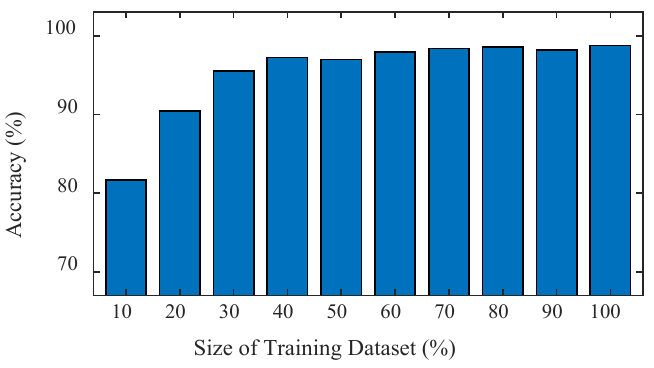
Figure 15. Effect of training data size on axle count classification. 100% size of training set = 10,000 samples (CNN-1).